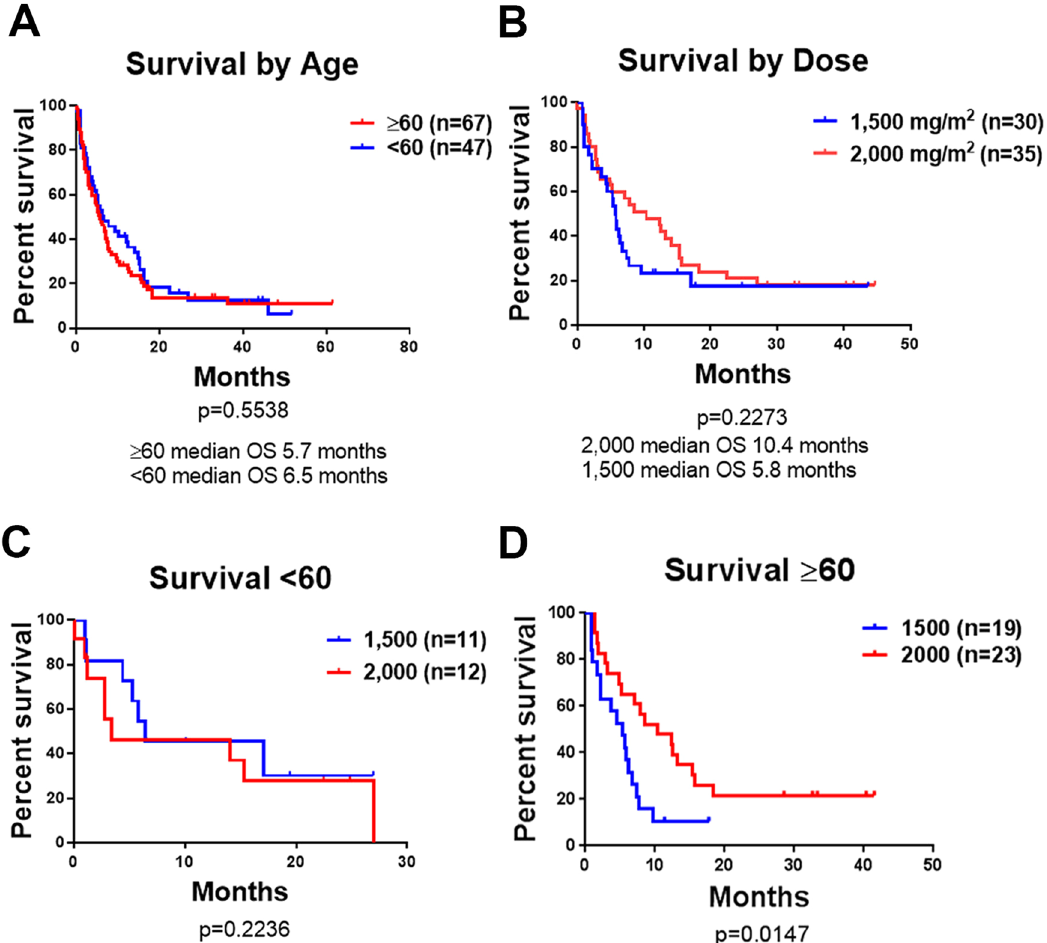
Fig. 1 Ef fi cacy of HiDAC, mitoxantrone, and devimistat. A Overall survival of the combined phase I and II cohorts by age. B Overall survival of the combined phase I and II cohorts by dose of devimistat. C Overall survival of the combined phase I and II cohorts by dose of devimistat for patients <60 years of age. D Overall survival of the combined phase I and II cohorts by the dose of devimistat for patients ≥ 60 years of age. Log-rank test was used to assess the difference between survival curves, P value less than 0.05 was considered signi fi